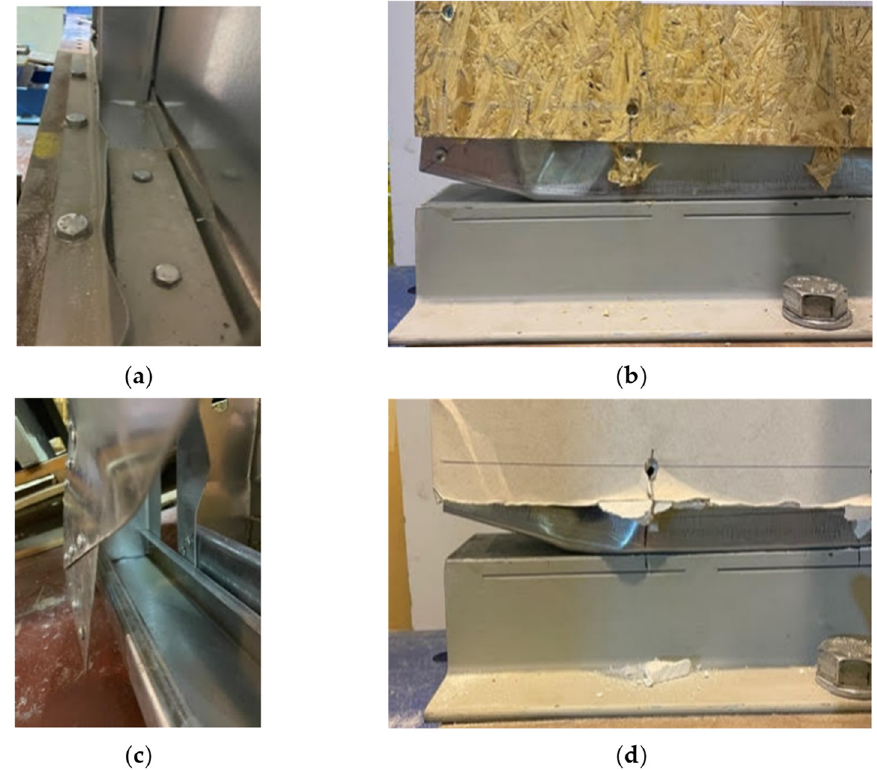
Figure 4. ( a ) Local buckling and yielding of the bottom track (partial failure mechanism), ( b ) tearing of the OSB (overall failure mechanism), ( c ) shear cut and pull out of fasteners (overall failure mech ‐ anism), and ( d ) tearing of the plasterboard (partial failure mechanism).